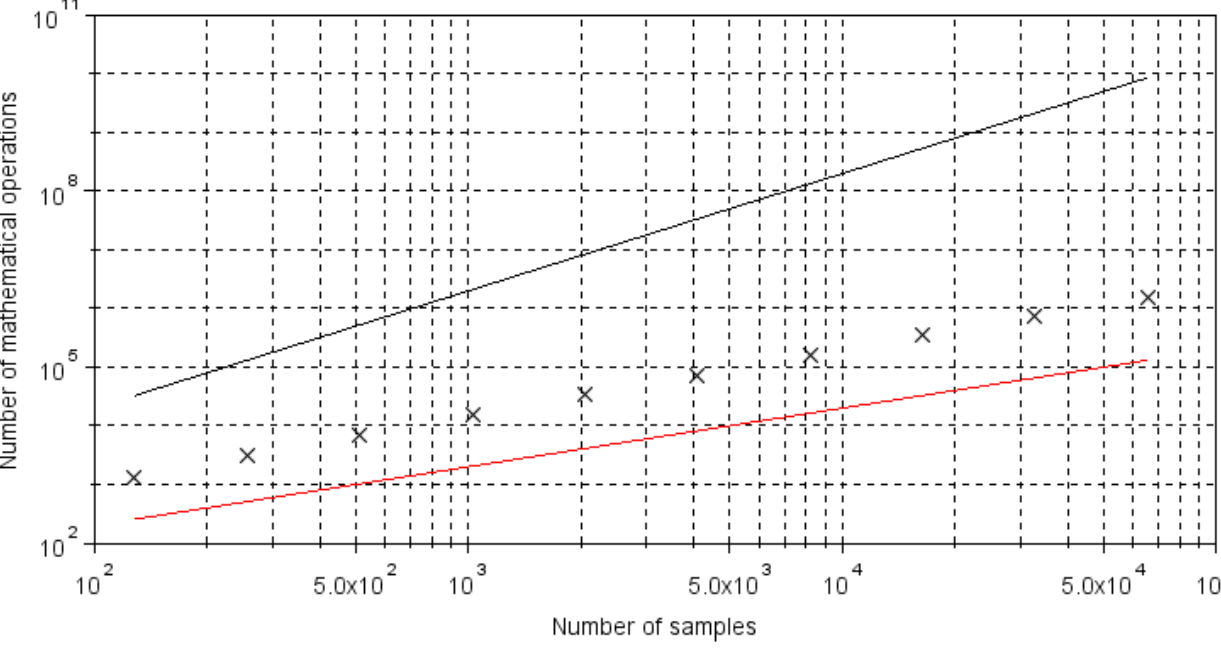
Figure 2. Computational complexity of DFT (black), FFT (crosses), and incremental decomposition (red).